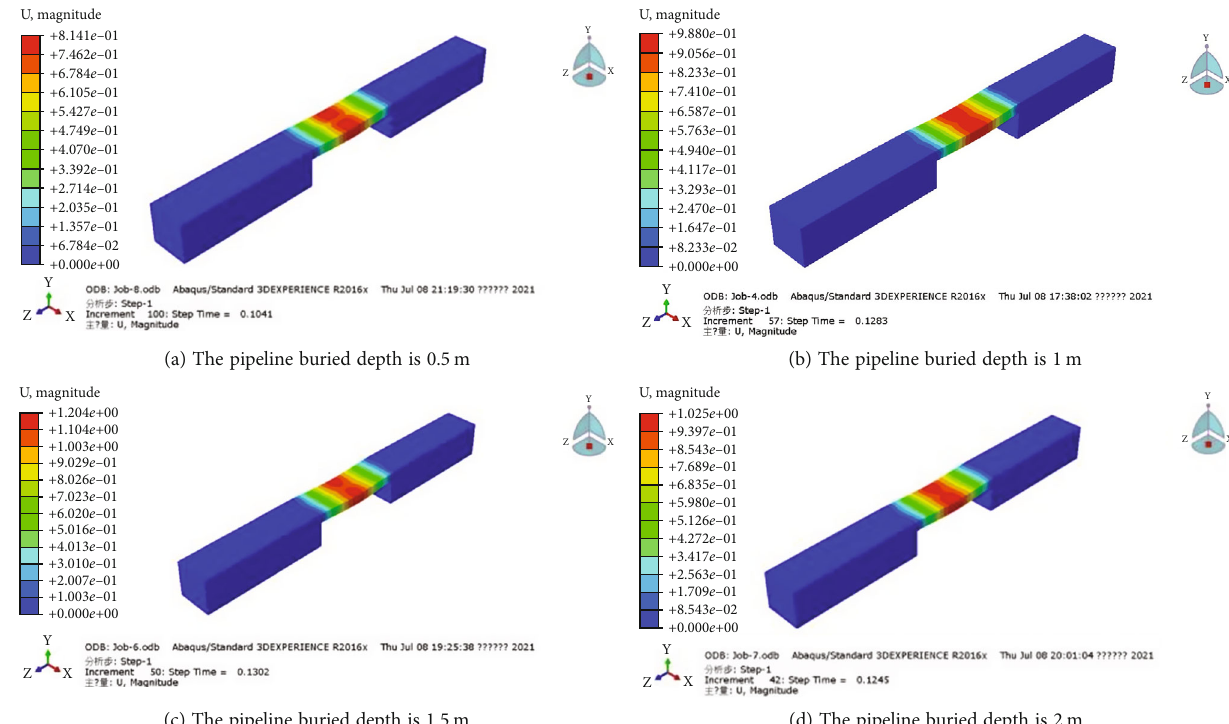
Figure 24: The soil displacement under di ff erent pipeline buried